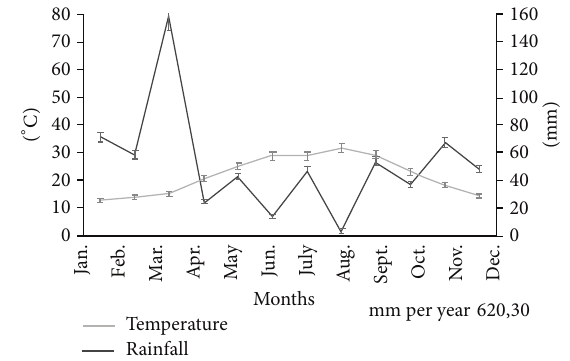
Figure 1: Bagnouls-Gaussen plot. Air temperature and rainfall data were collected by a meteorological station during the summer season 2011 in CRA-PLF experimental site.